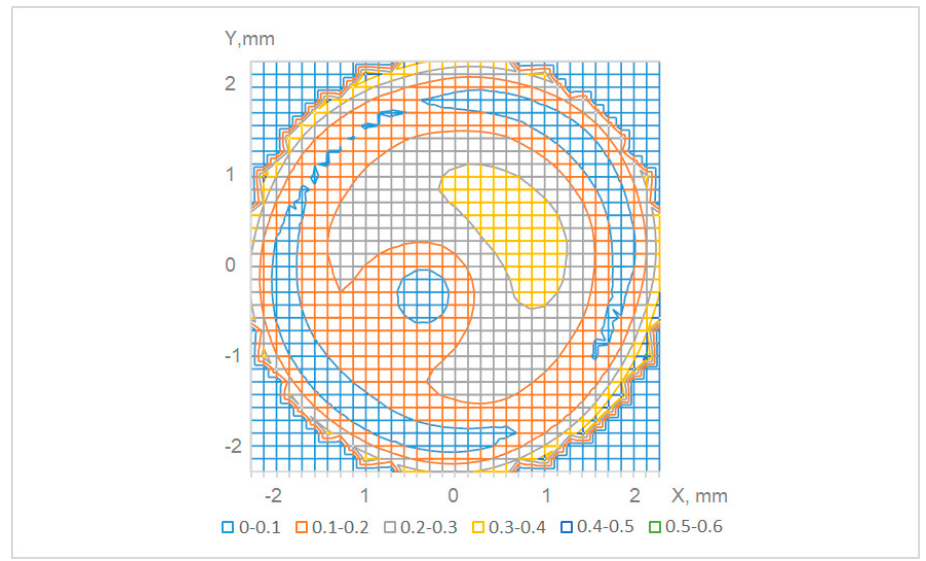
Figure 4. Modulus of shift vectors’ length for various points of the sensor. Different colors corre- spond to different ranges of length, measured in 1 tenth of the pixel size. to different ranges of length, measured in 1 tenth of the pixel